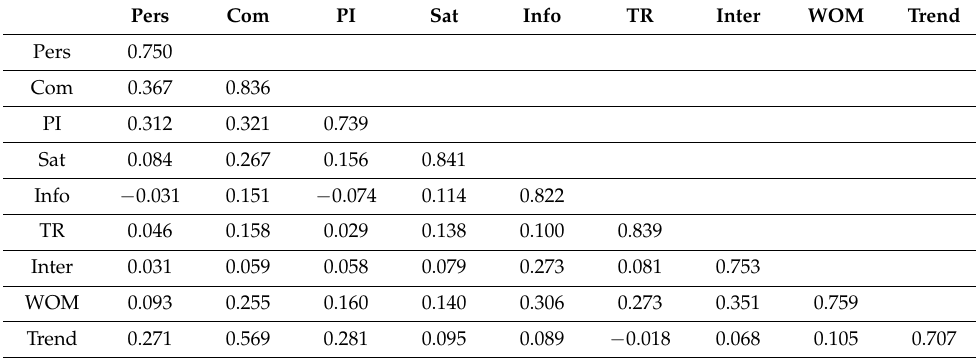
Table 3. Construct validity and inter-construct